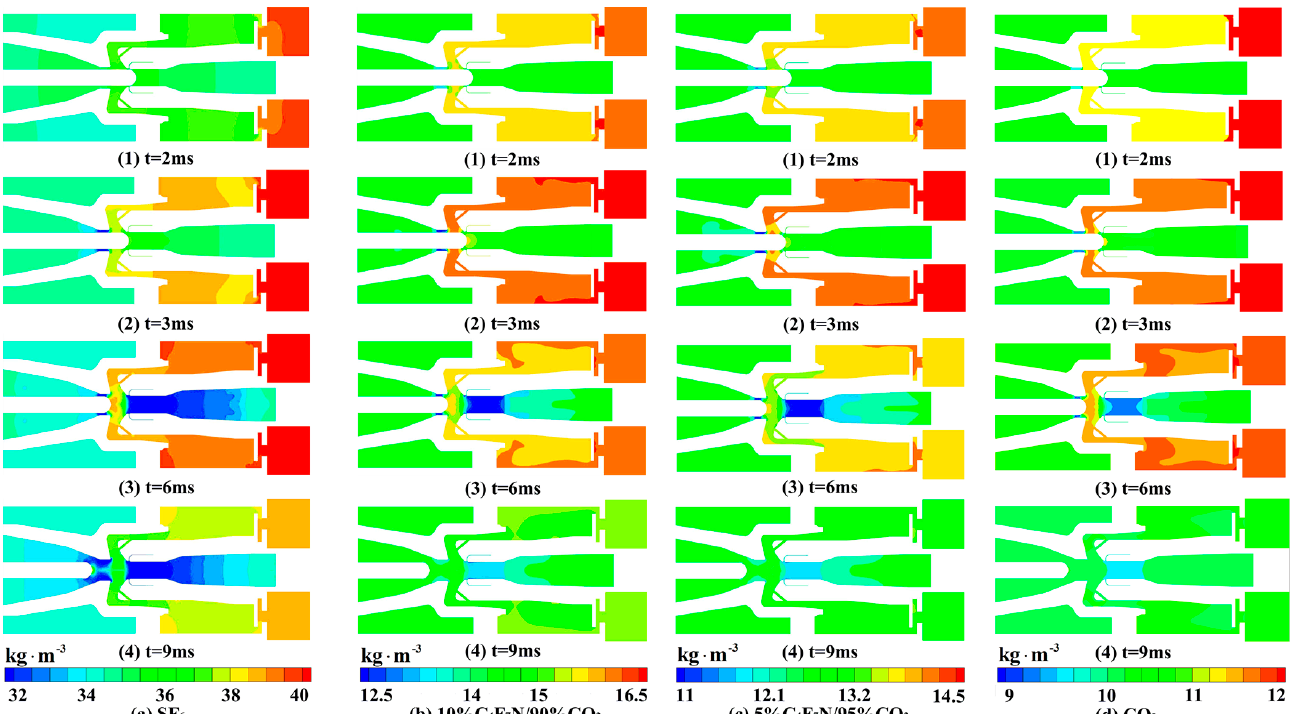
Figure 7. Arc extinguishing chamber density distribution cloud map.